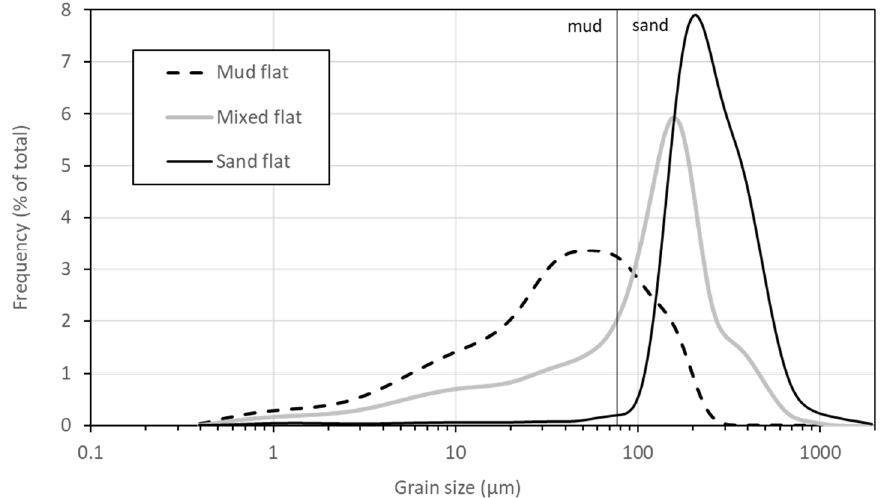
Figure 3. Frequency distribution curves of the mud, mixed and sand flat sub-depositional environments revealing how laser particle size analysis data were used to differentiate tidal flat sediments.